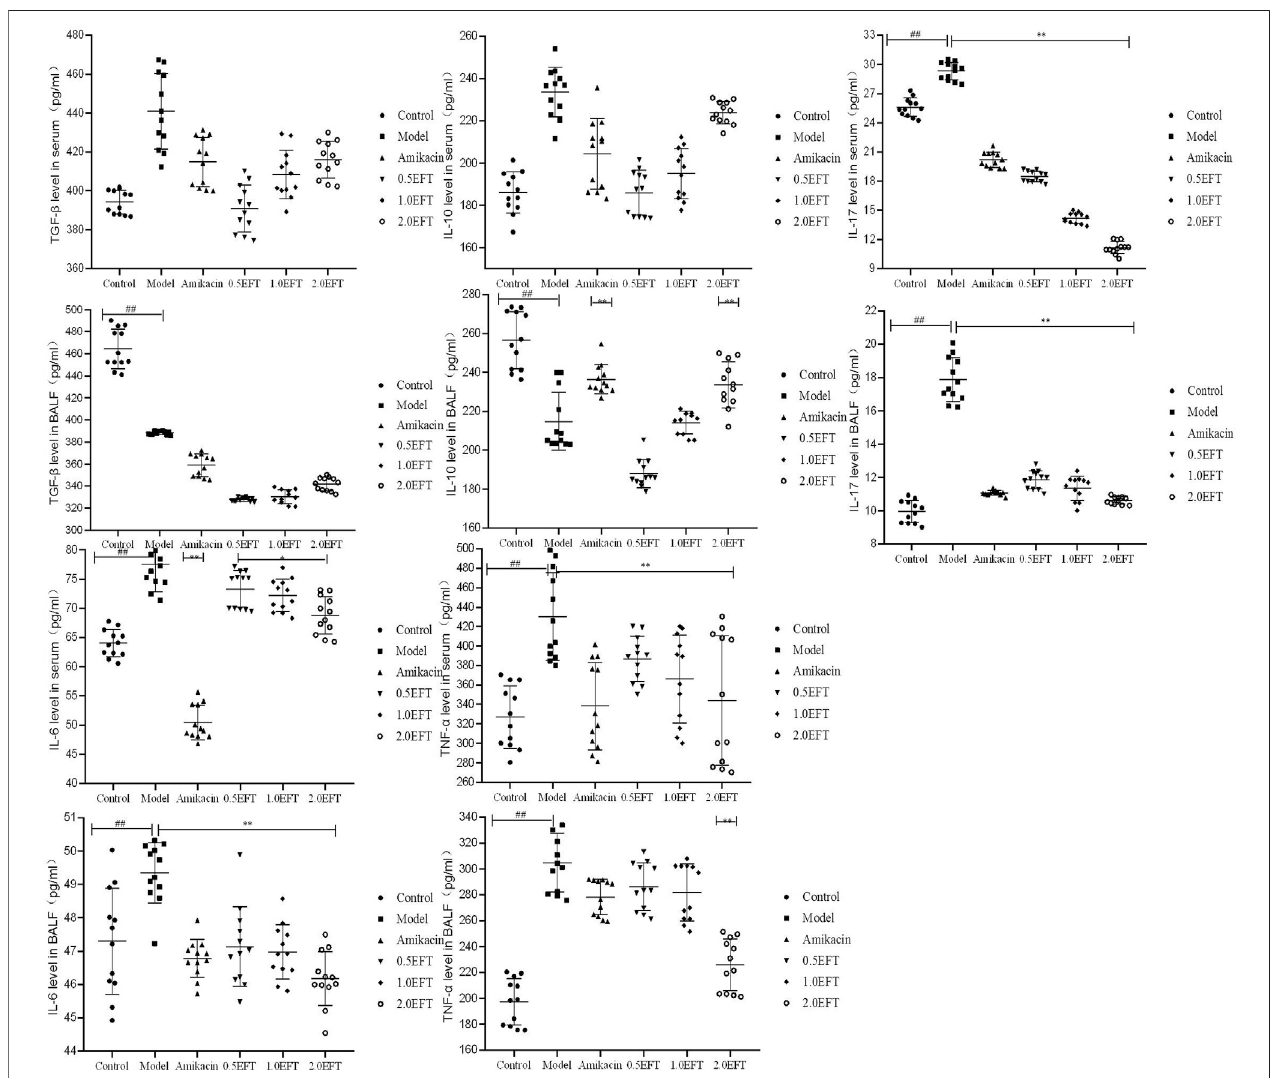
FIGURE6| EffectsofEFTonin fl ammatorycytokineinserumandBALFsofeachmicegroup.Allvaluesareexpressedasmean ± SD( n (cid:2) 12).# p < 0.05;## p < 0.01 compared with the control group, * p < 0.05; ** p < 0.01 compared with the model group.